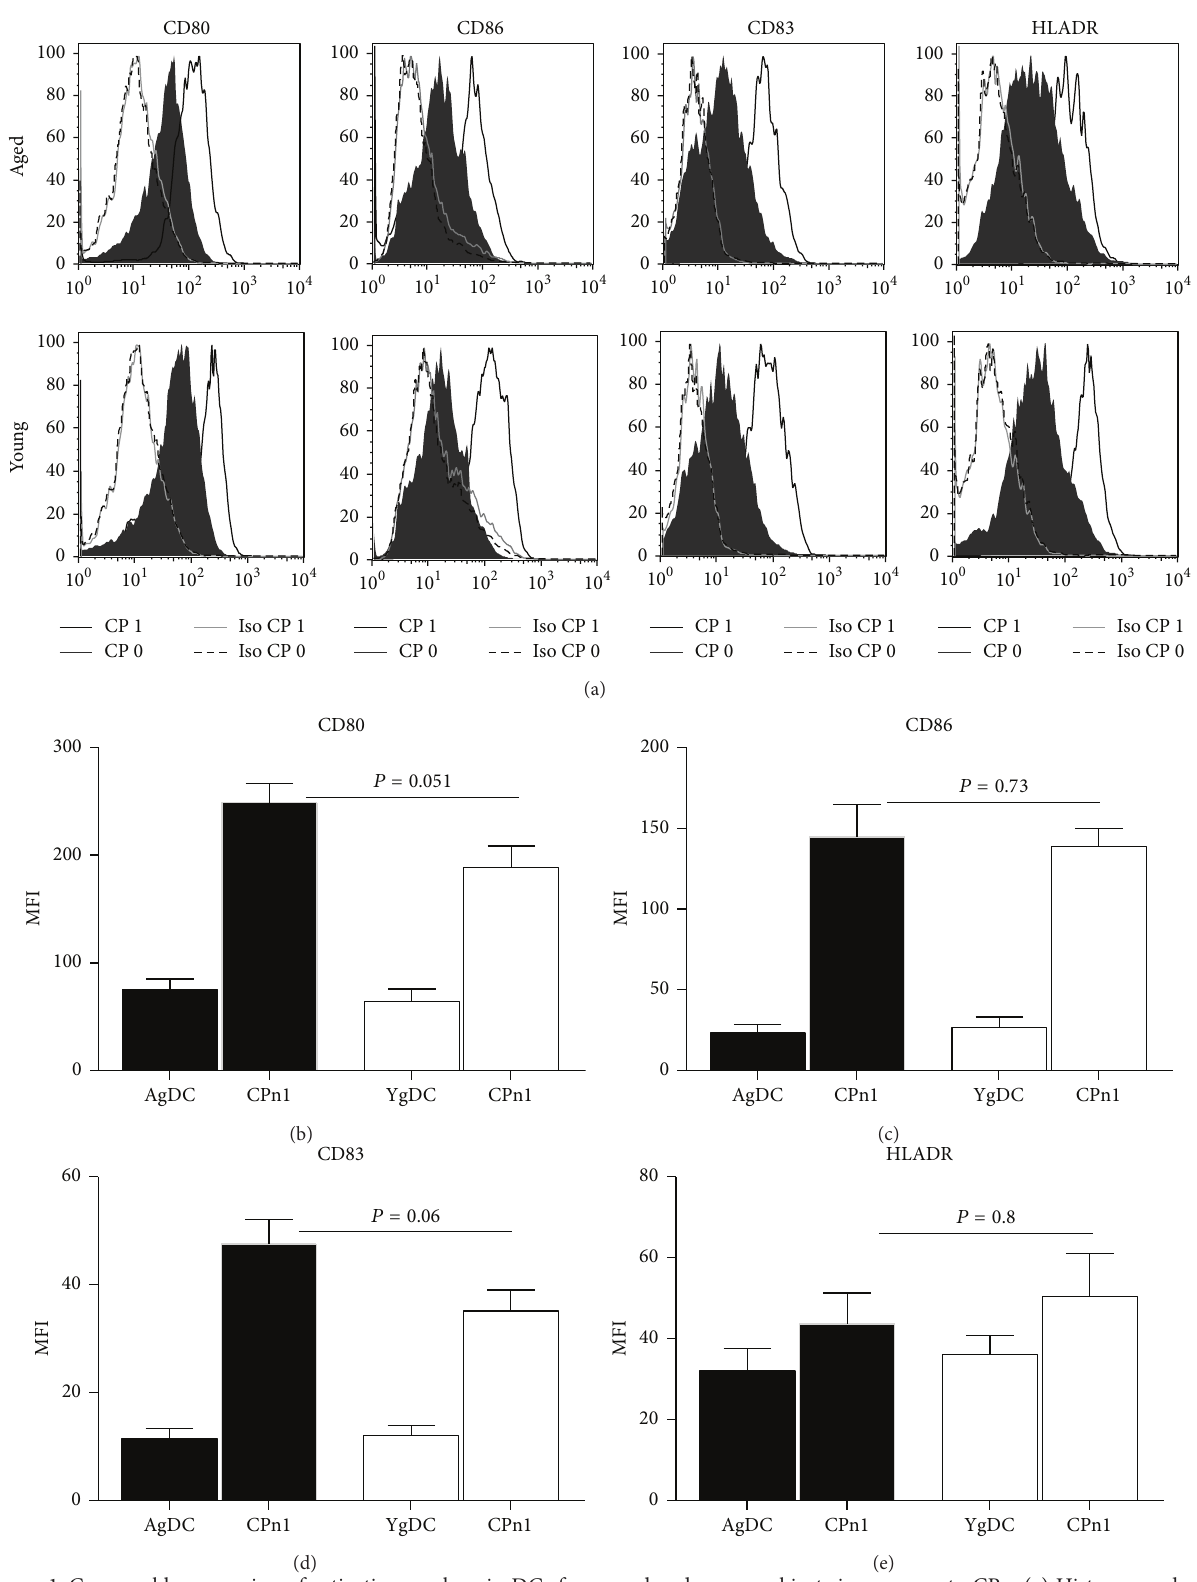
Figure 1: Comparable expression of activation markers in DCs from aged and young subjects in response to CPn. (a) Histograms depict the expression of activation markers on DCs from aged and young subjects after on stimulation with CPn. Bar graphs depict the MFI of the expression of activation molecules on CPn stimulated DCs from aged and young subjects. (b) CD80; (c) CD86; (d) CD83; (e) HLADR. Data is mean +/ − S.E of 12 aged and 12 young subjects. 𝑃 value depicted is comparison of CPn-stimulated DCs from aged subjects with their young